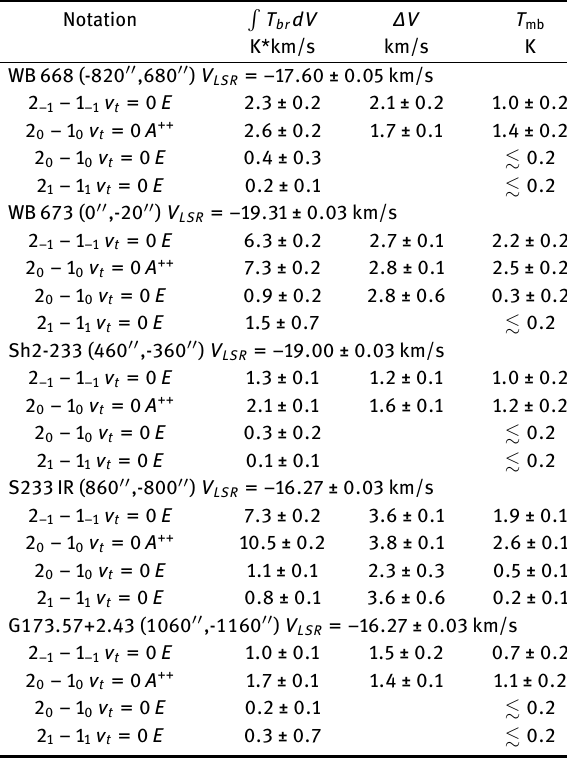
Table 2. Methanol lines quartet at 96.7 GHz has been detected in the clamps. Offset positions are given relative to α (J2000.0) =